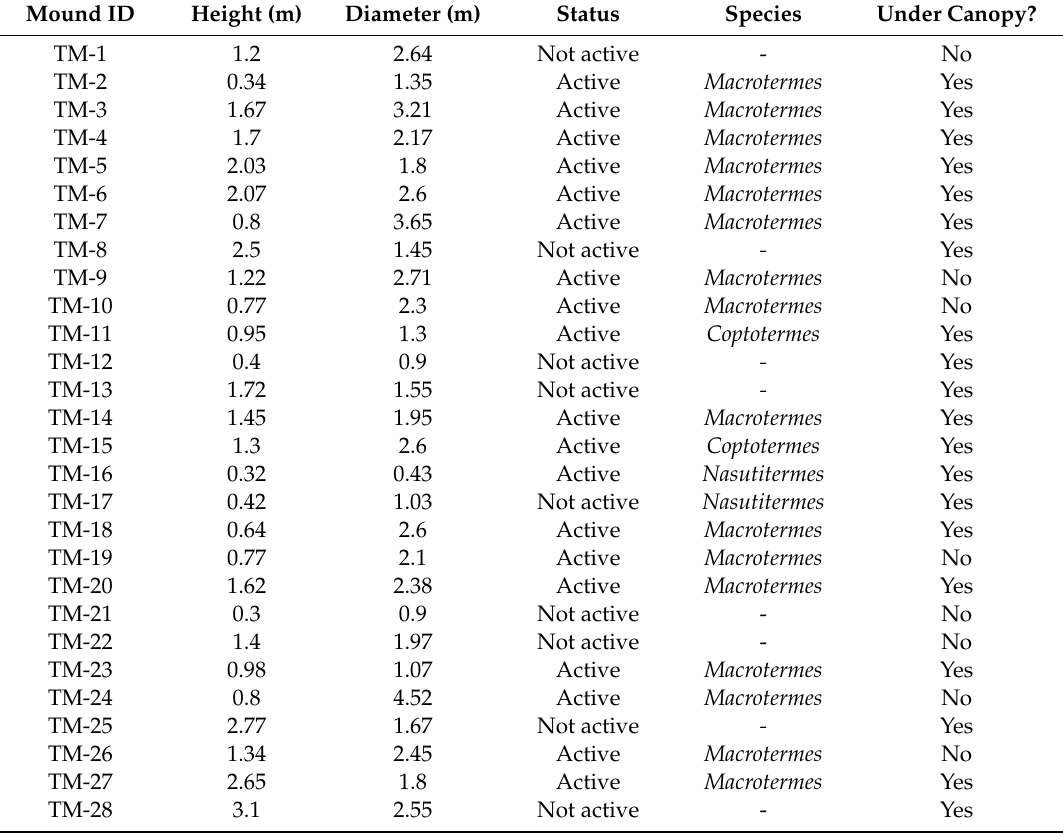
Table 1. Summary of physical characteristics of surveyed termite